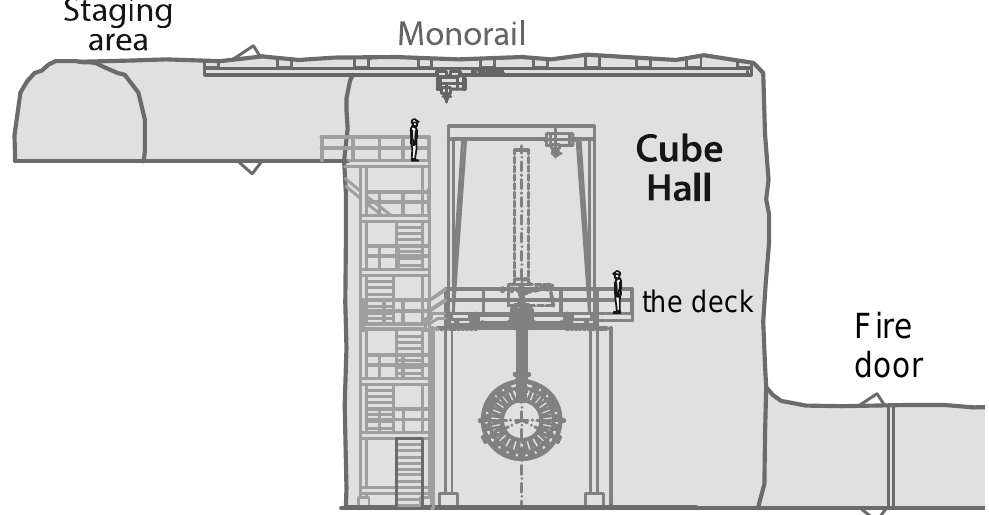
The Physikalisch-Technische Bundesanstalt established an underground laboratory for dosimetry and spectrometry at the Asse salt mine, near Braunschweig, where a coaxial low-background HPGe detector with extended shielding was exploited [23]. A detailed investigation of the dose rate within the underground low-level background laboratories at the Unirea salt mine (Slanic-Prahova) has shown a relatively uniform distribution varying between 1.3 ± 0.3 nSv h − 1 outside the Low-Level Background Laboratory (LLBL) and 1.6 ± 0.3 nSv h − 1 inside it [24,25]. This measurement was performed by means of a calibrated scintillator rate meter. Two rounds of measurement of ambient dose rate were obtained at a significant number of points situated inside the Praid salt mine, by using the very sensitive Romanian thermoluminescent dosimetry (TLD) system, as reported in [26]. Authors in [26] showed a consistency between gamma-ray spectrometry results and results from the TLD-based system.